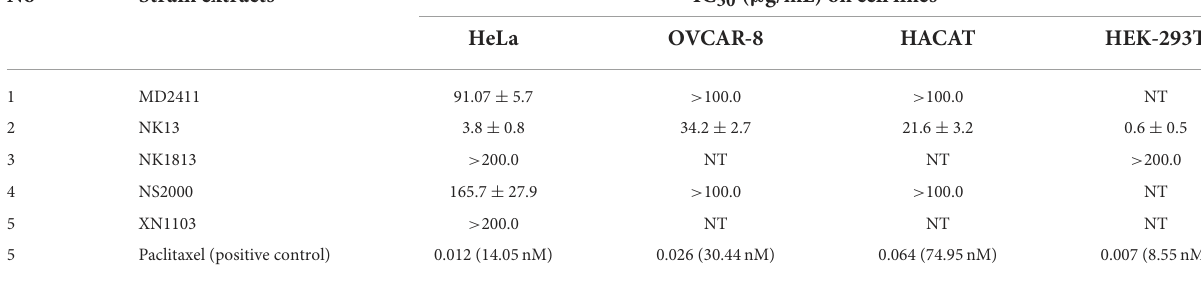
TheboldvaluesindicatethepercentageidentitiesoftherbcLgeneregionbetweenisolatedstrainandreferencestrainswithinagenus.Thetotalalignmentlengthwas700bpincludinggap positions. TABLE 4 Cytotoxic activities of total extracts from five isolated cyanobacterial